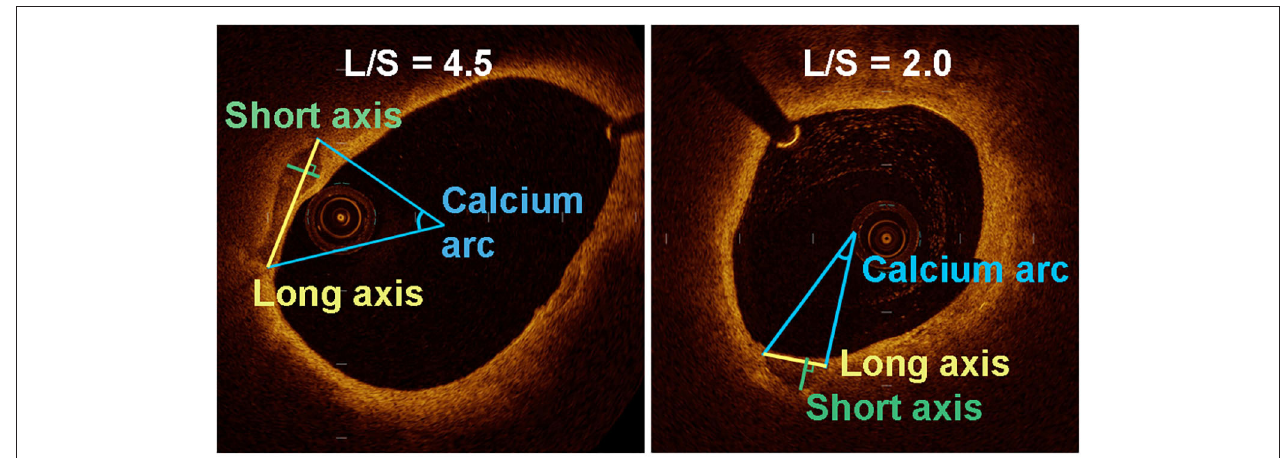
FIGURE 1 | Quantitative analysis of various parameters for the assessment of long axis and short axis in a transverse section of an OCT-image of two plaques with different calcification shape.